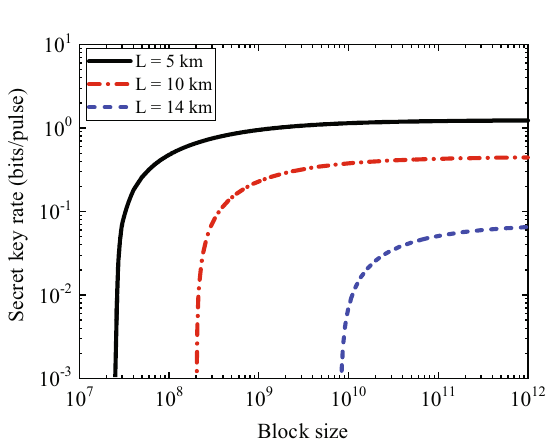
Figure 3. Secret key rates as functions of block size of the CV-SDI QKD protocol. The black solid line shows the performance with the distance of 5 km. The red dot-dashed line and the blue dashed line are the key rates of the protocol with distances of 10 km and 14 km, respectively. The other parameters are as in Fig.